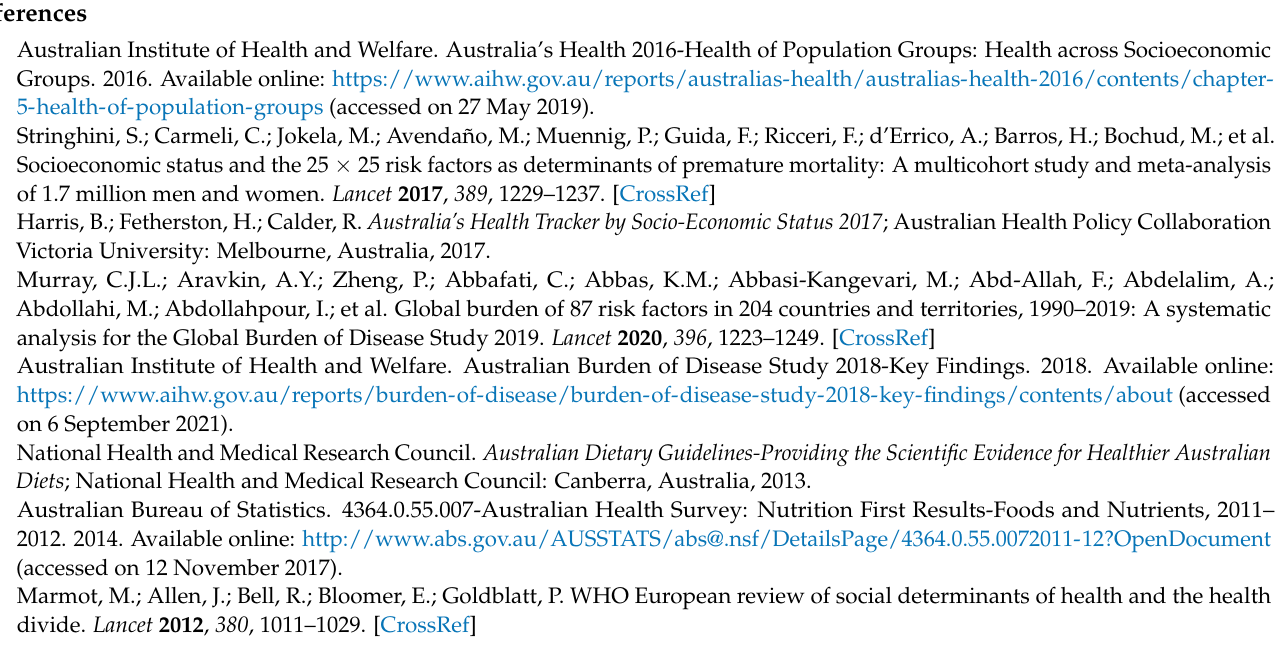
Table S2: Composition of the habitual diet of each SEG, and the recommended diet, for the reference household (two adults, two children), Table S3: Habitual diet costs of each SEG and recommended diet costs, for the representative household (two adults, two children), Figure S1: Habitual diet serves per fortnight (as per Australian Dietary Guidelines) for each SEG for a reference household (two adults, two